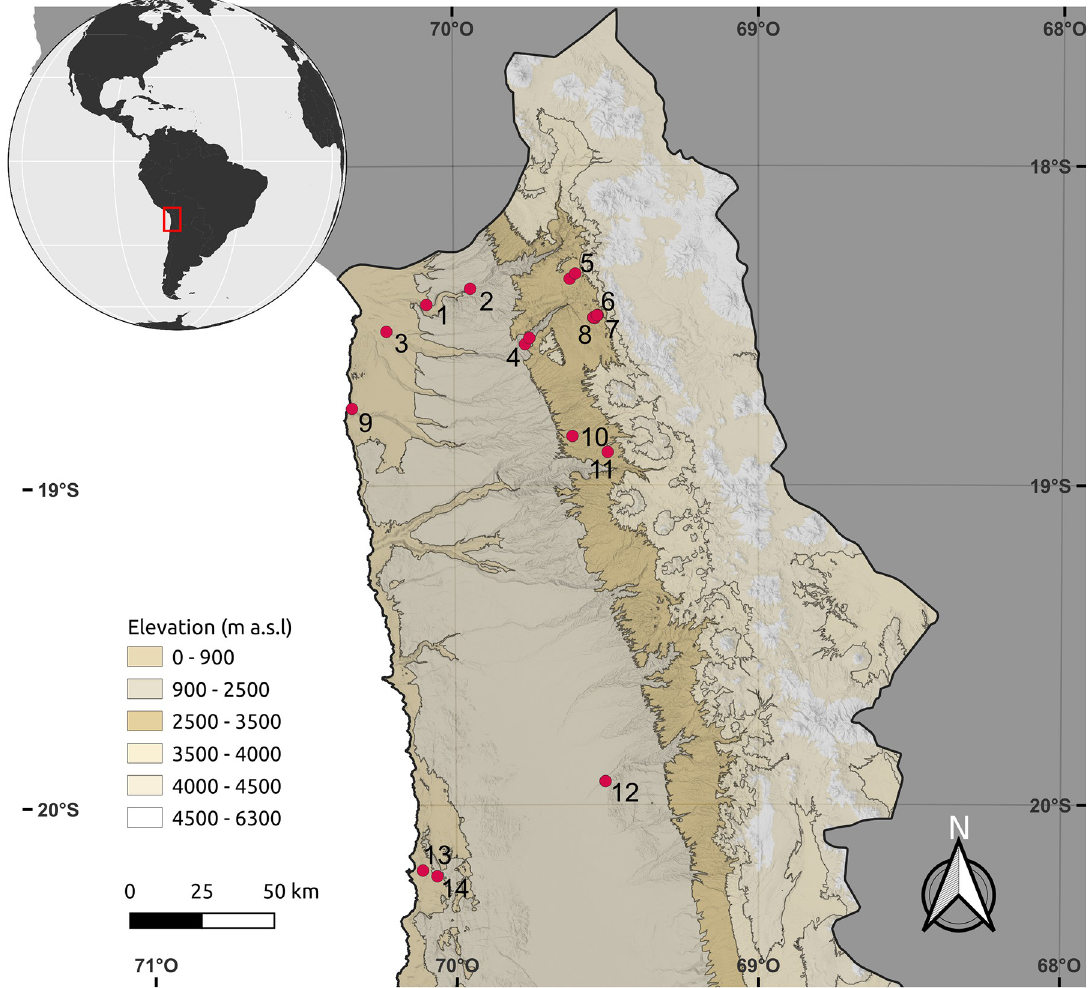
Fig 2. Distribution of the main sites where imperial Inka elements have been recorded in the provinces of Arica, Tarapaca´, and Atacama. (1) Molle Pampa ( ushnu , chullpas ); (2) Cruces de Molino (petroglyphs); (3) Azapa 15 (cemetery, ushnu , geoglyphs); (4) Pubrisa (village, monumental architecture); (5) Zapahuira complex ( tambo , qolqas , Qapac Ñan , huairas ); (6) Chajpa and Ancopachane architectural compounds; (7) Huaihuarani (hilltop village including plaza, domestic and ceremonial architectures); (8) Molle Grande (pictograph with red and white checkerboard); (9) Caleta Vitor Bay; (10) Inkahullo village ( sunturhuasi cosmological architecture); (11) Saguara 2 village (domestic and ceremonial architectures: ushnu ); (12) Tarapaca´ Viejo village; (13) Cerro Esmeralda (hilltop burial); (14) Huantajalla (silver mine) (map courtesy of Matias Frugone) . the archaeological record as Tomb N˚1 by Chris Carter [96]. Located on a vertical plane on the eastern edge of zone CV2, the tomb became exposed due to deep and extensive excavations carried out by the Chilean Navy in 1960. In addition to the unku , the tomb contained a bow, a clutch of six arrows positioned vertically beside the funerary bundle (Fig 4A), four camelid fiber bags (three square-shaped chuspa s and one rectangular talega , or domestic bag) (Fig 4B), a leather breastplate, a vegetal fiber mat, a vegetal fiber capacho (backpack), and two truncated cone hats with twisted chinstraps and stepped geometrical designs made from a flat, rigid, veg- etal fiber base interworked with camelid fiber (Fig 4C) [96:193]. The arrows, made entirely of wood, consist of two parts: the shaft (average length of 43.7 cm), which is stained with red ochre except at the proximal segment where the feathers are attached; and the arrowhead,